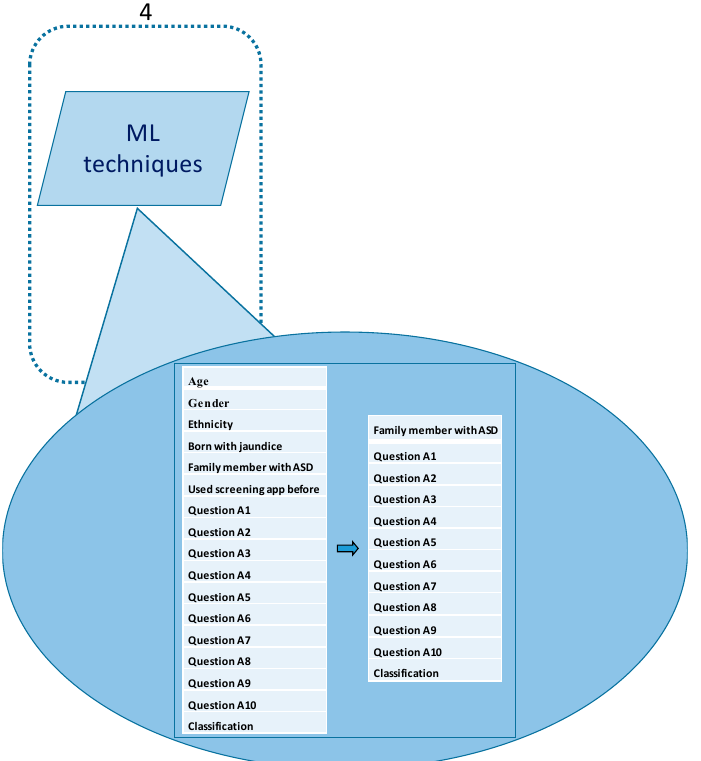
Figure 3. Dimensionality reduction from 19 attributes to 12. This reduction helped to apply the distributed approach, as every test was reduced by almost half.